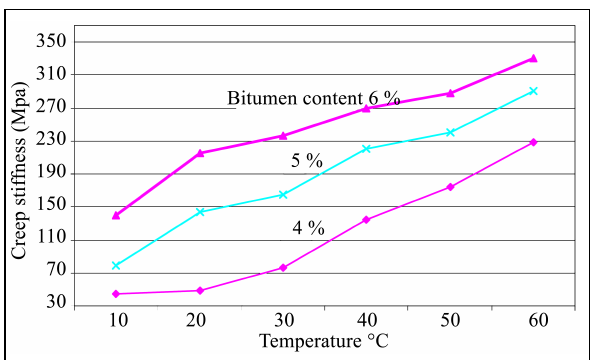
Fig 5. Effect of bitumen content and temperature on creep stiff- ness